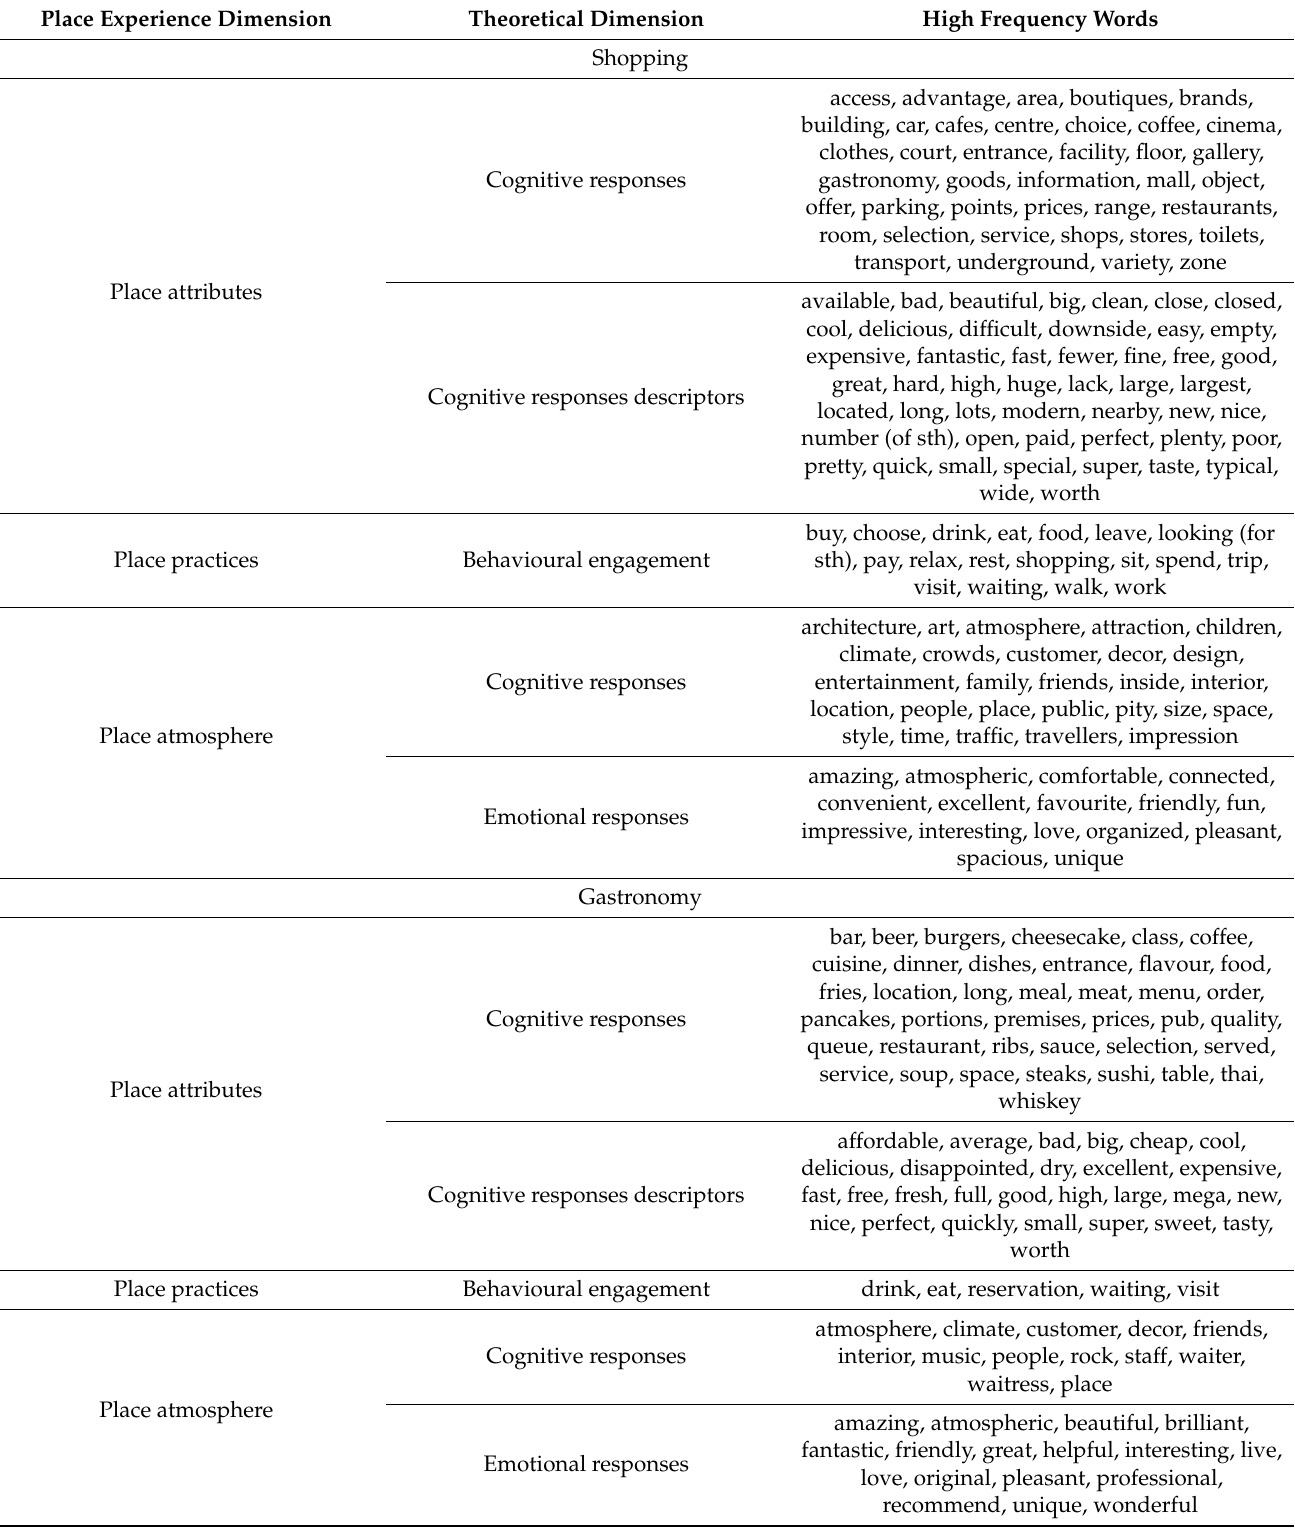
Table 4. Dimension of place experience divided into place